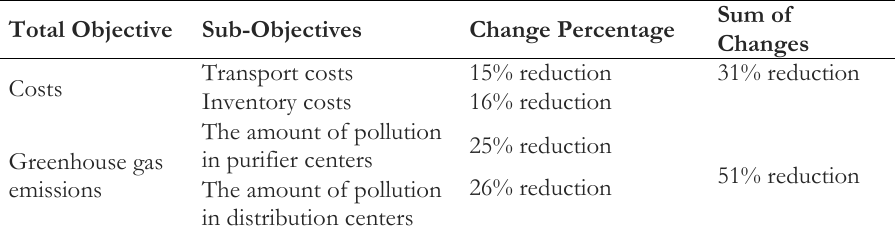
Table 2. Results of objectives based on the proposed model.